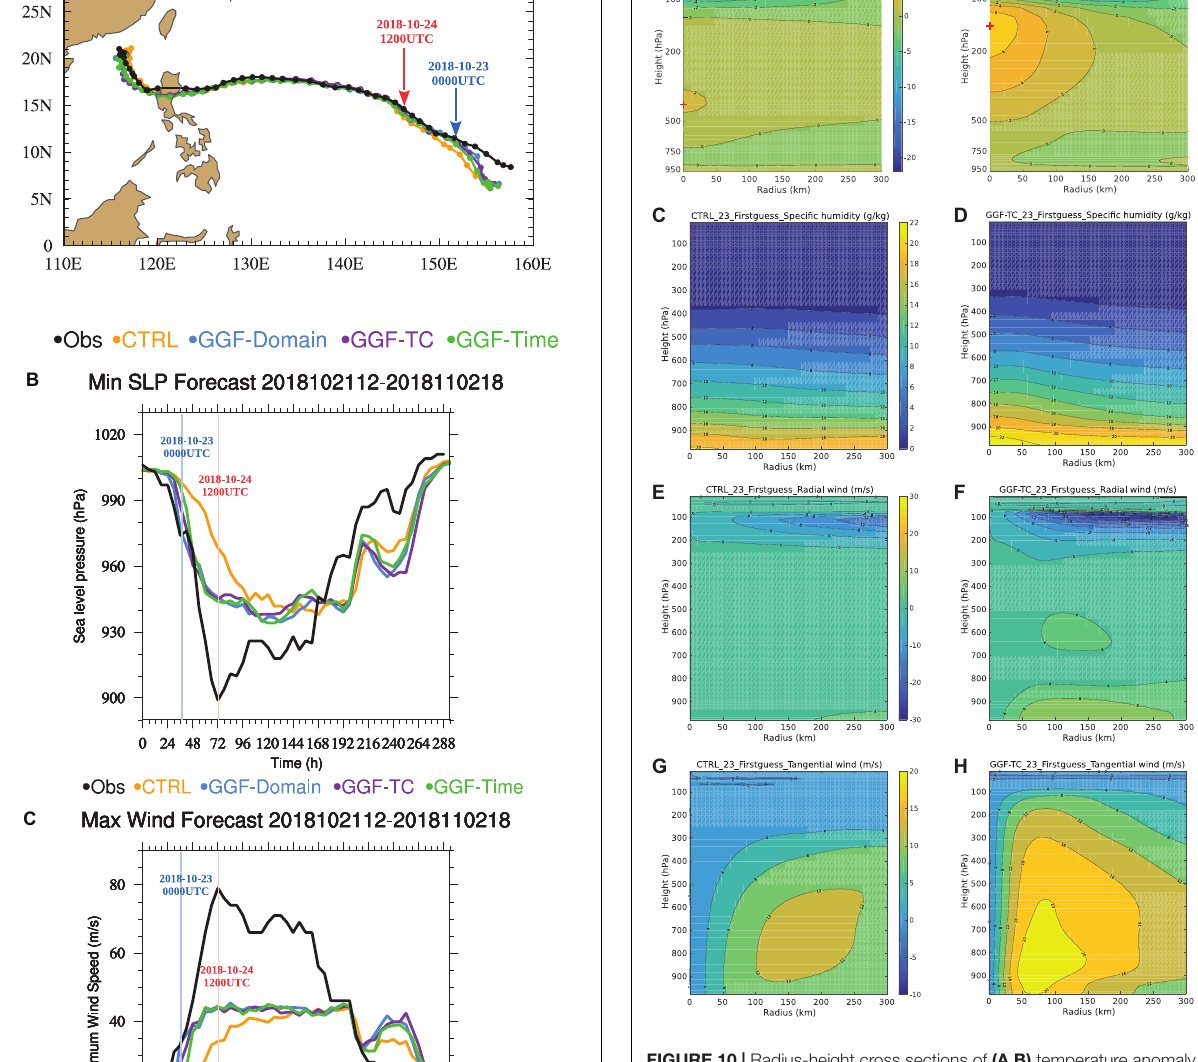
FIGURE 10 | Radius-height cross sections of (A,B) temperature anomaly that has the mean temperature in a 1000 km radius deducted for each level, (C,D) specific humidity, (E,F) radial wind, and (G,H) tangential wind at 0000 UTC 23 October 2018. Left panels for experiment CTRL, and right panels for experiment GGF-TC. The red plus in (A,B) denotes the location of warm core. Please note that in order to better display the structure of temperature anomaly, log pressure is used as vertical axes for panels (A,B) while pressure is used for the other panels. and secondary circulations, warm cores and humidity of the posteriors are more prominent than those of the priors due to data